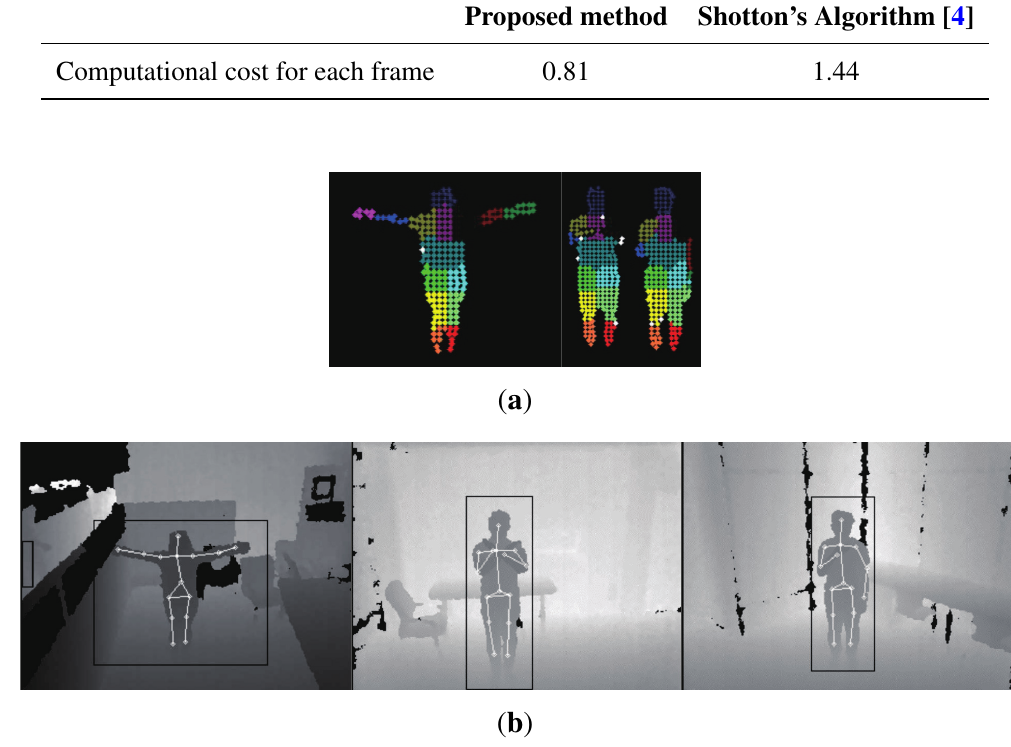
Figure 8. Experimental results of pose estimation. ( a ) Superpixels classification results; ( b ) pose estimation